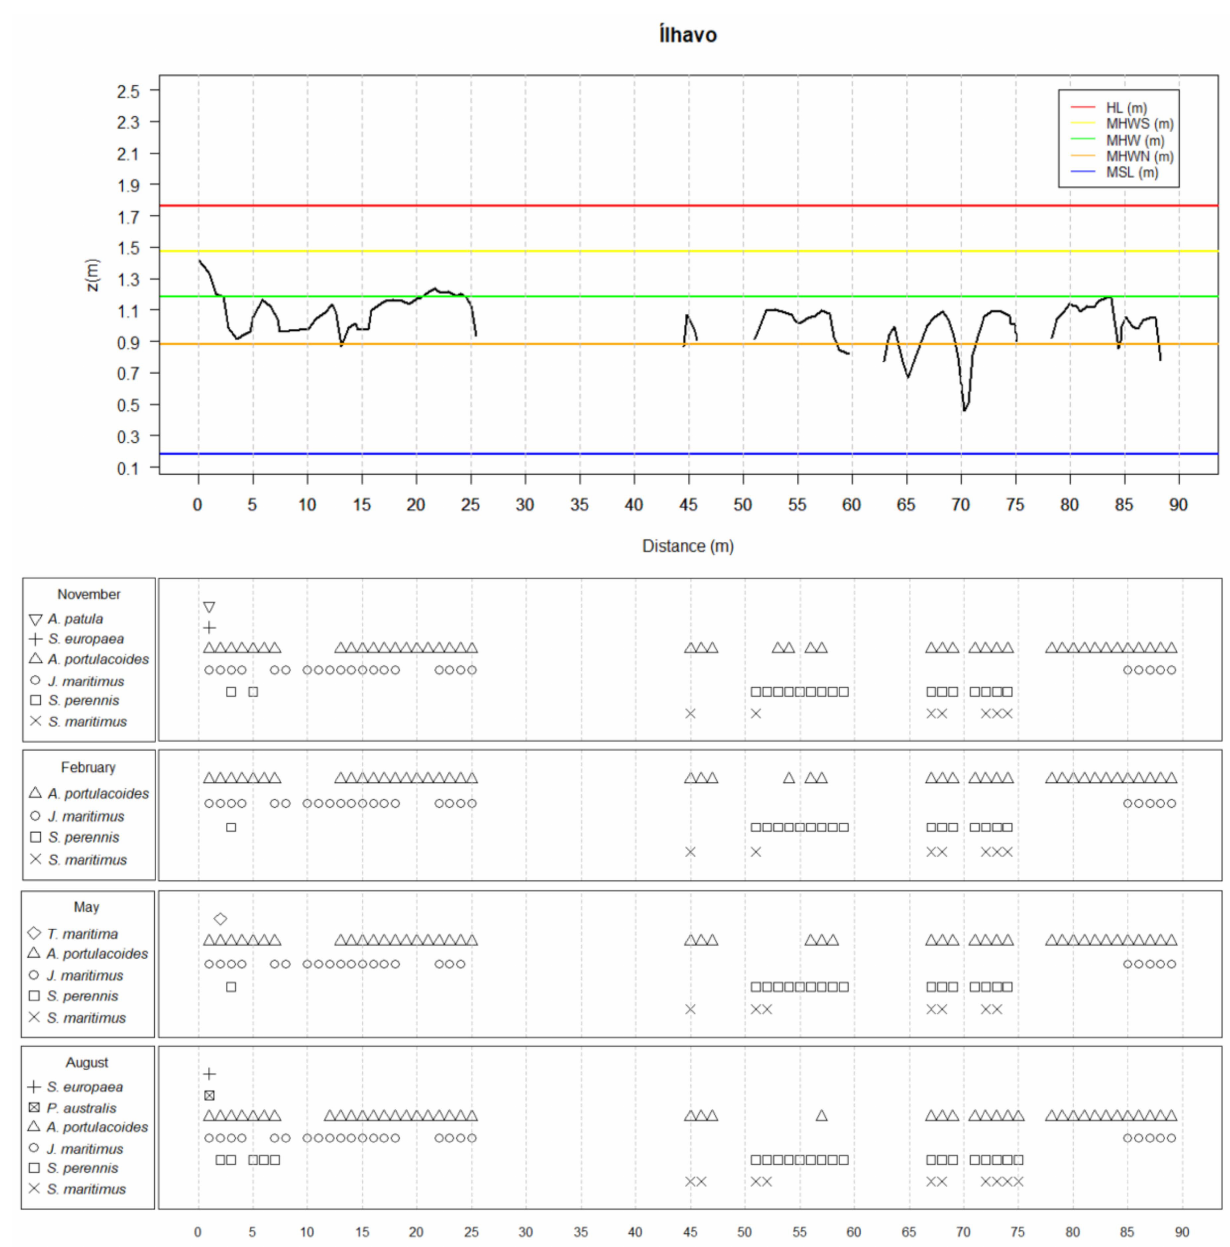
Figure A3. Topographic profile of Í lhavo ´ s salt marsh and its respective tidal levels. HL (highest tidal level), MHWS (mean high water springs), MHW (mean high water), MHWN (mean high water neaps), MSL (mean sea level). Representation of vegetation distribution through the length of